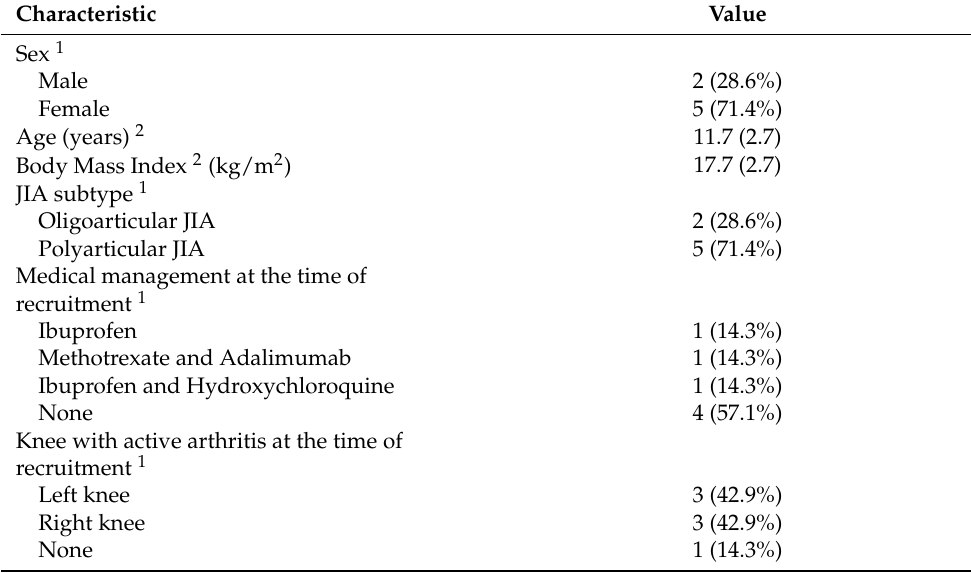
Table 2. JIA diagnosis and details of clinical assessment for the